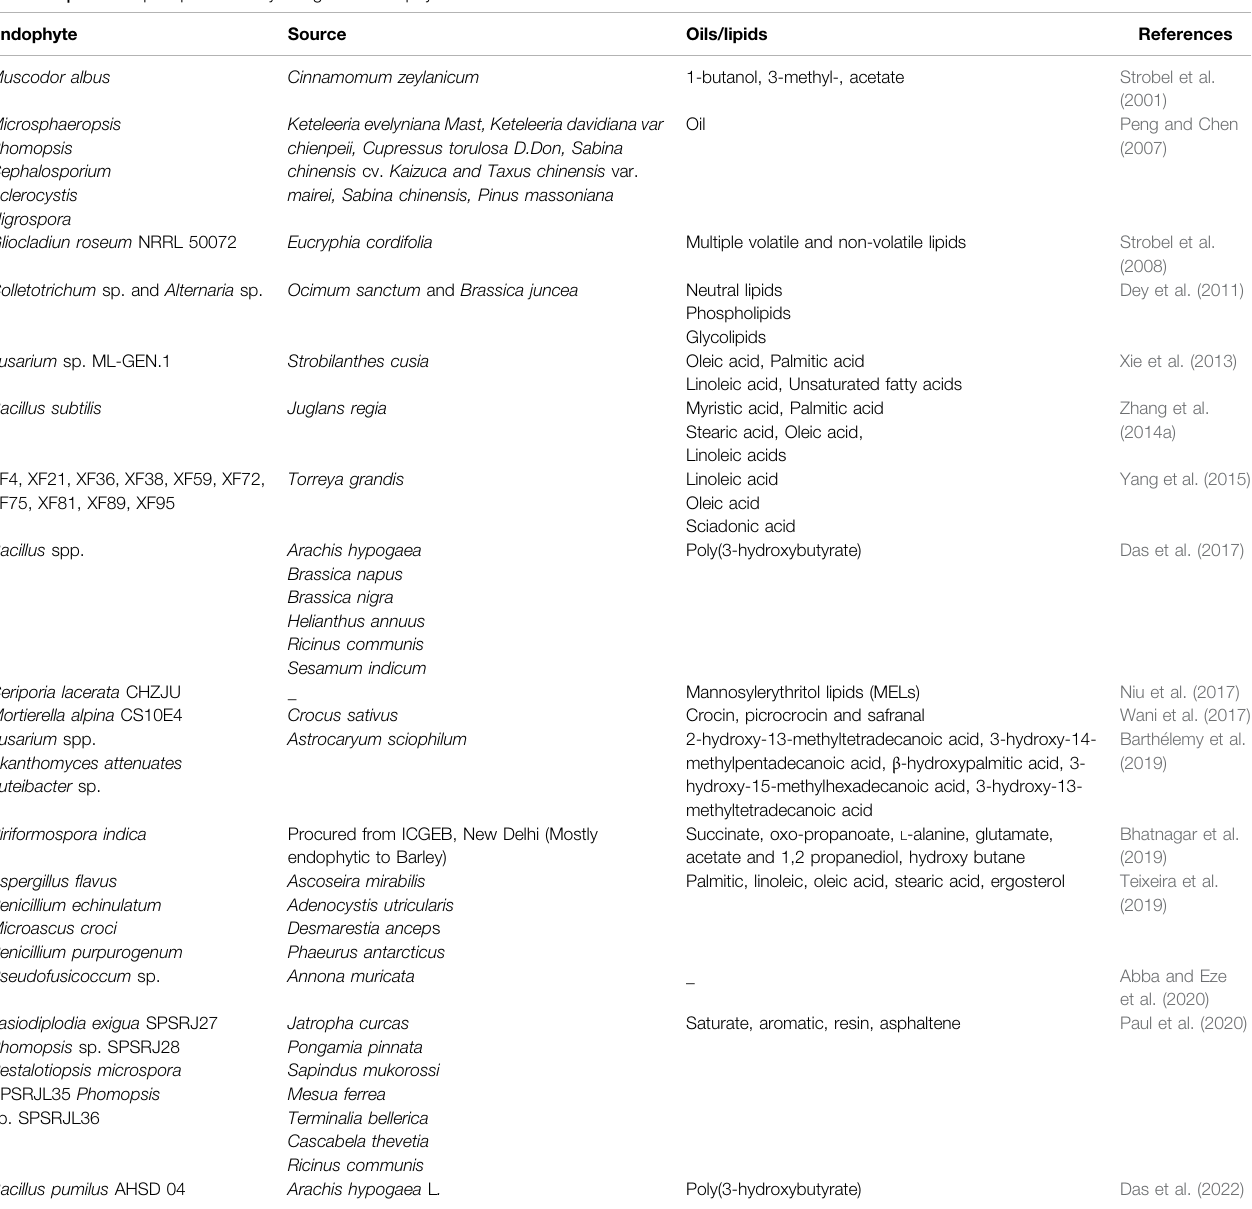
TABLE 4 | Various lipids produced by oleaginous